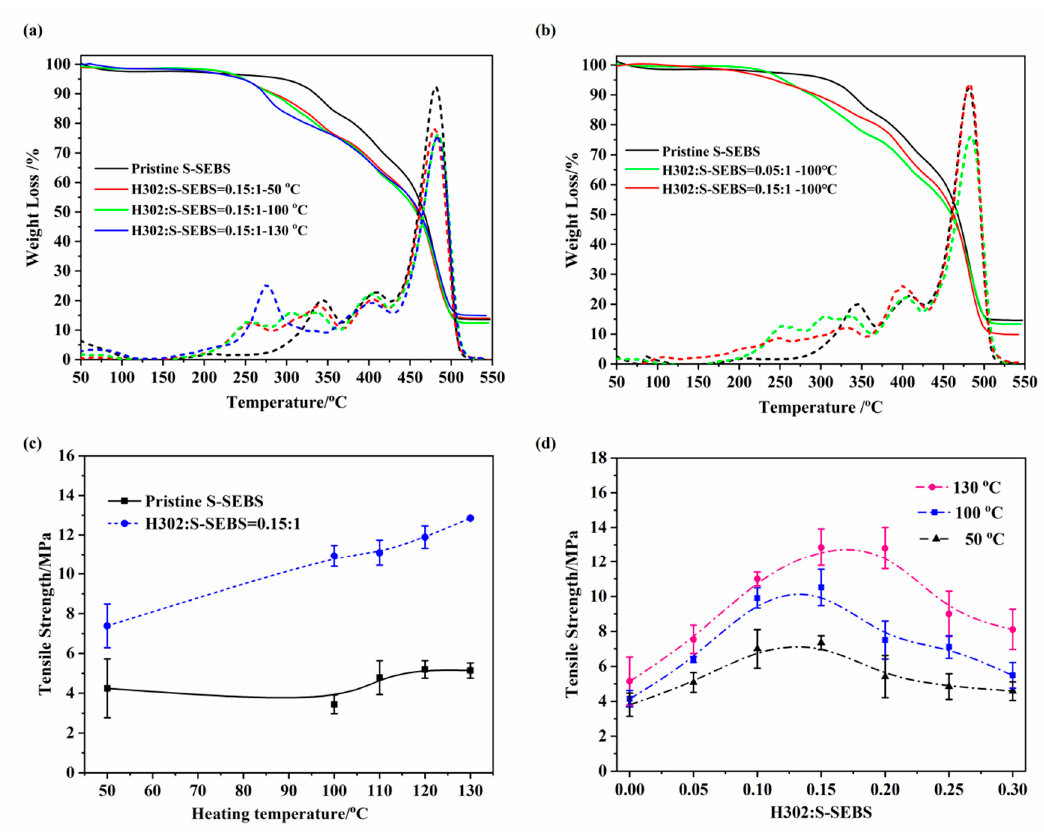
Figure 9. TG ( a , b ) and tensile strength ( c , d ) of membranes with different treating temperatures and H302 contents.